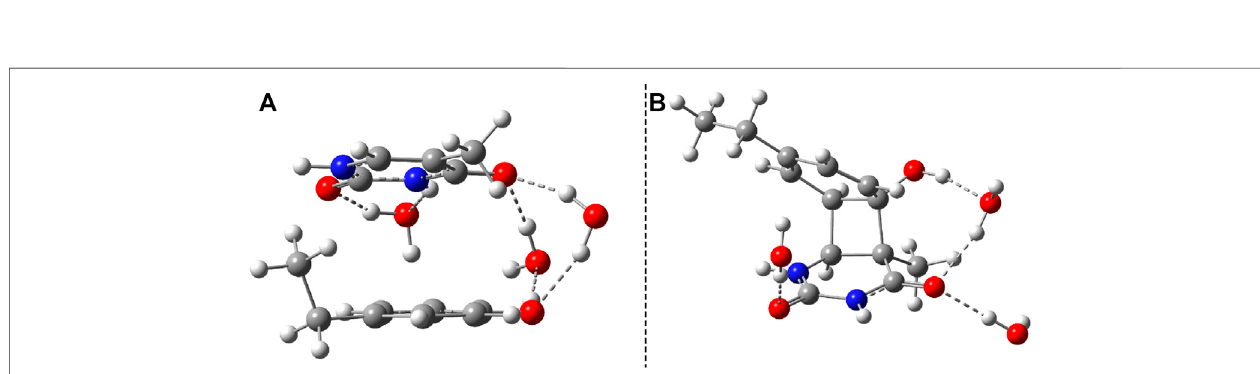
FIGURE9| Theequilibriumgeometriesofthestacking (A) andcyclicadduct (B) betweenphenolanduracilunitsinthephenol – uracil(P – U)complexobtainedatthe TD- ω B97X-D3/ma-def2-TZVPP level of theory.